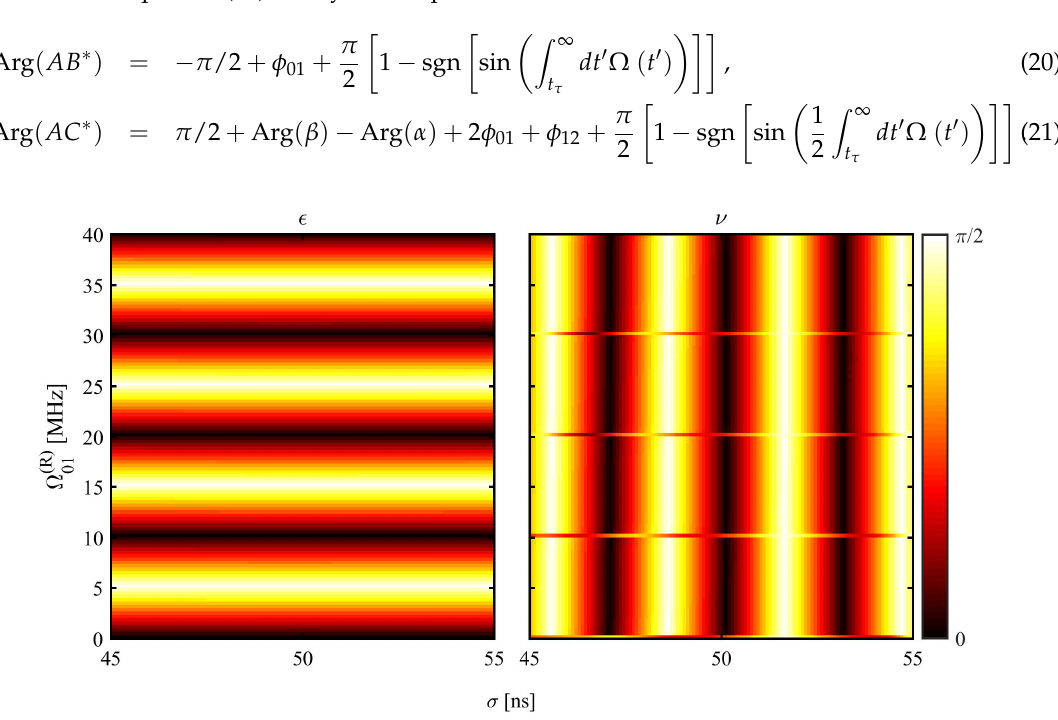
Figure 3. The magnitude of the wavefunction coefficients in spherical coordinates, (cid:101) and ν , as a function ( R ) of the Rabi pulse amplitude Ω and the duration of the STIRAP pulses σ . The horizontal lines in the 01 right plot result from the numerical instability when | A | = | B | = 0 and ν is undefined. The parameters ( 0 ) = Ω ( 0 ) = 37.5 MHz, t s / σ = 2, and σ = 50 ns. of the simulation are φ 01 = π /3, φ 12 = π /4, Ω 01 12 The simulation agrees with the adiabatic-approximation analytical result Equation